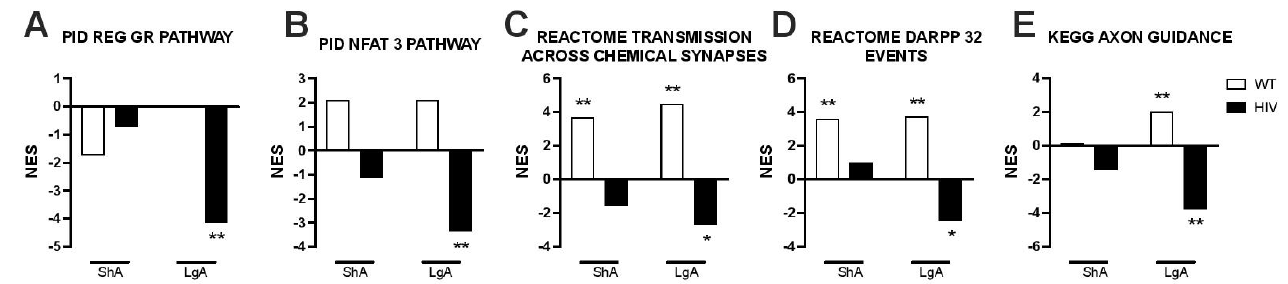
Figure 6. Differential regulation of selected pathways by histories of nondependent (ShA) and dependent (LgA) oxycodone self-administration in HIV Tg rats and WT rats. The figure shows the differential regulation of gene sets that are relevant to neurodegeneration in HIV Tg rats and WT rats with histories of nondependent (ShA) and dependent (LgA) oxycodone self-administration. ( A ) Glucocorticoid regulated genes showed greater adaptations in HIV Tg rats with a history of dependent (LgA) oxycodone self-administration. ( B ) Nfat3 regulated genes, ( C ) genes that are involved in neuronal communication, including synaptodendritic genes, ( D ) genes that are related to signaling, such as DARPP32 regulated events, and ( E ) genes that are related to axonal function were downregulated in HIV Tg rats with a history of dependent (LgA) oxycodone self-administration. * p < 0.05, ** p < 0.01, vs. oxycodone-naive control rats of the respective genotype. NES = normalized enrichment score [60].